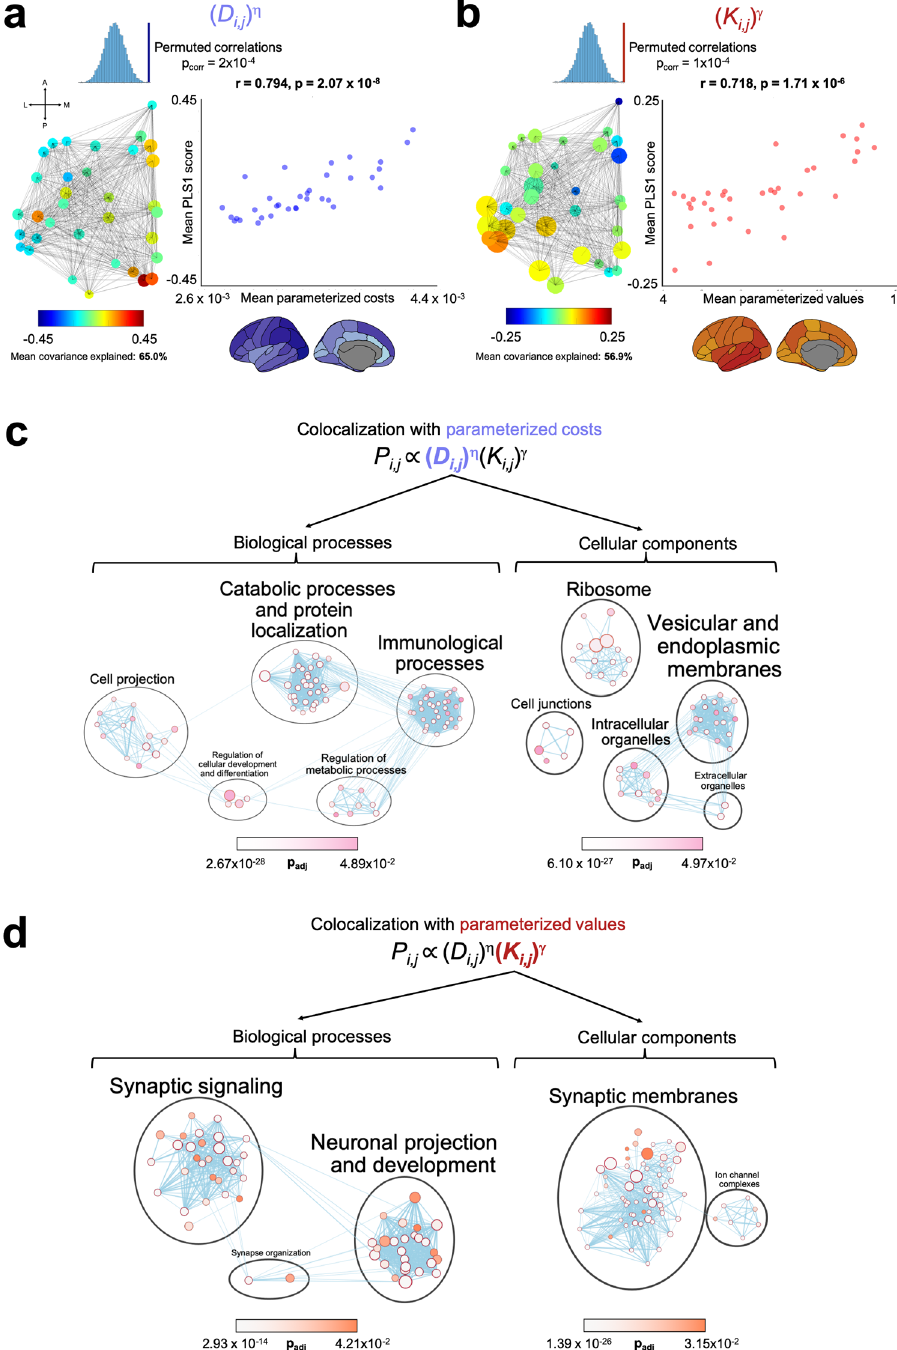
Fig. 7 Over expressed genes which explain variance in brain wiring across subjects. Both PLS1 components across subjects are enriched for functionally speci fi c biological processes and cellular components. Node size represents the number of genes in the set. The edges relate to gene overlap. a Sample- averaged parameterized costs signi fi cantly correlates with sample-averaged PLS1 nodal gene scores, explaining on average 65.0% covariance. Statistics were computed via two-tailed linear correlations, quoting the Pearson ’ s correlation coef fi cient, followed by n = 10,000 permutations. b Sample-averaged parameterized values signi fi cantly correlates with sample-averaged PLS1 nodal gene scores explaining on average 56.9% covariance. Statistics were computed via two-tailed linear correlations, quoting the Pearson ’ s correlation coef fi cient, followed by n = 10,000 permutations. c Nodal costs PLS1 is enriched for genes predominantly associated with protein localization, catabolic processes, and ribosomal/membrane cellular components. d Nodal values PLS1 is enriched for genes predominantly associated with synaptic signaling, neuronal projection and synaptic